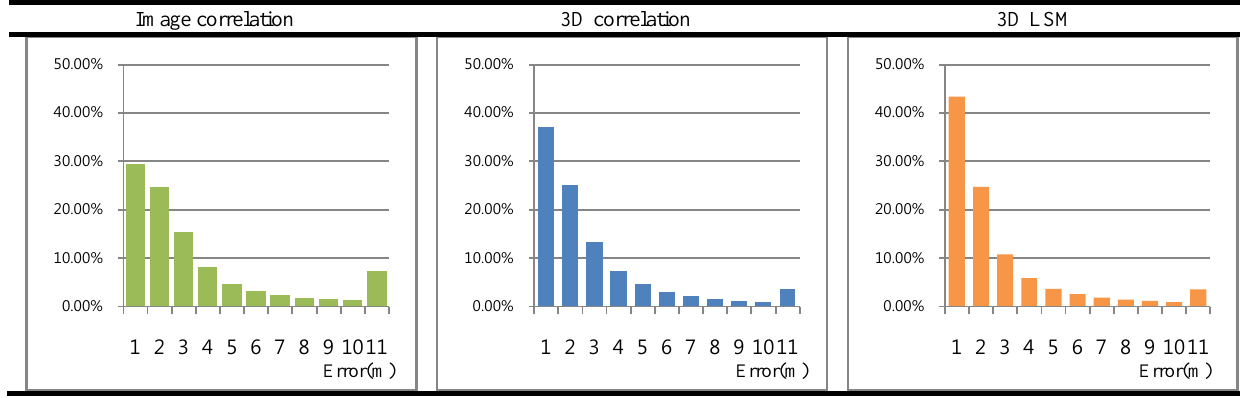
Figure 5. Histogram of DEM